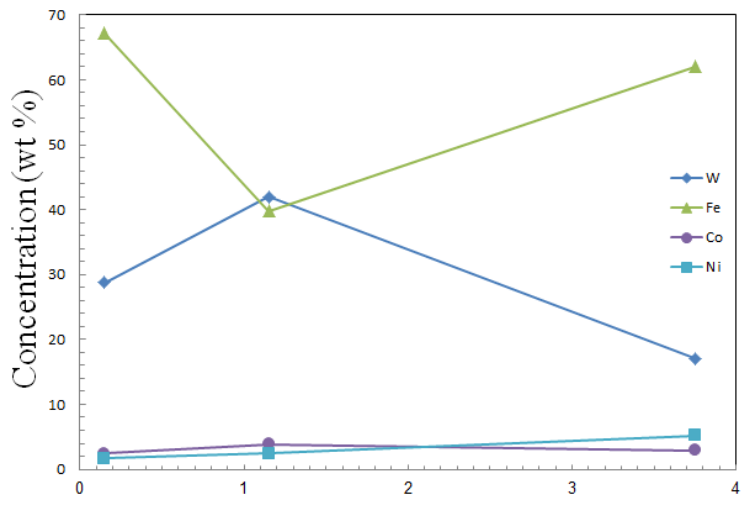
Figure 10. Variation of value elements on surface with spark energy. Figure 10 . Variation of value elements on surface with spark energy. Figure 10 . Variation of value elements on surface with spark energy.